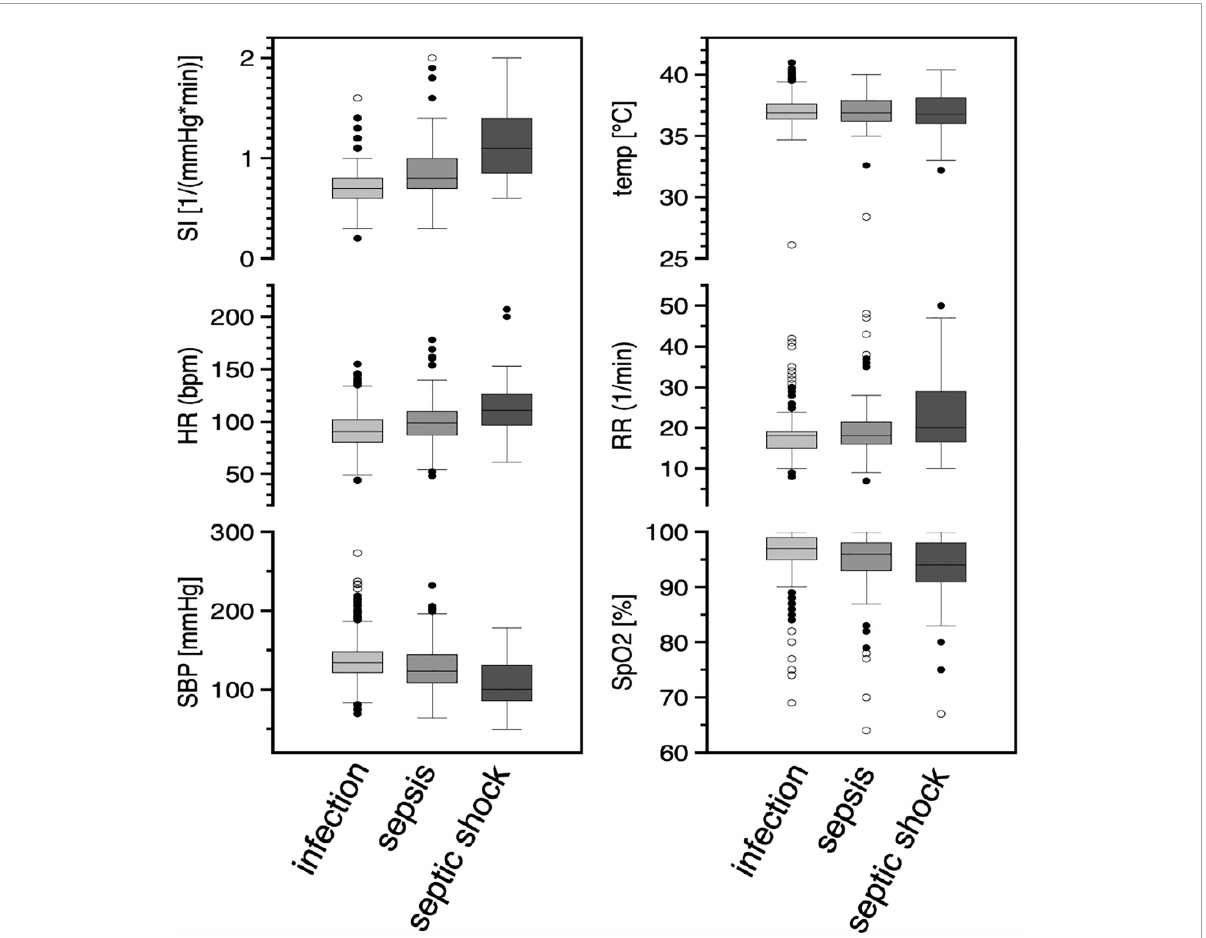
FIGURE2 Vital signs in the three subgroups of patients. Results were illustrated as box-and-whisker-plot with 25 and 75%-quantiles (box) median (bar), 1.5X interquartile range and outliers (circles) in the three subgroups (I: infection n = 1,103, II: sepsis n = 133, III: septic shock n = 42). Abbreviations: SI, shock index; HR, heart rate; SBP, systolic blood pressure; temp, temperature tympanal; RR, respiratory rate; SpO2, oxygen saturation by pulse